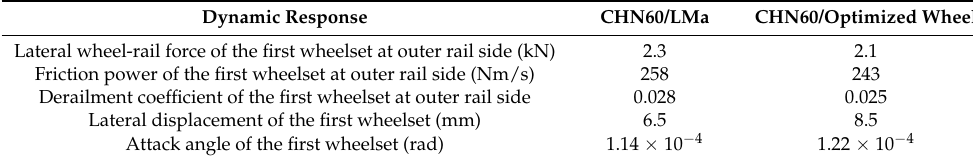
Figure 24. Vehicle curve negotiation performance indexes. ( a ) Lateral displacement of the first wheelset; ( b ) Yaw angle of the first wheelset; ( c ) Wheel friction force of the first wheelset at the outer rail side; ( d ) Derailment coefficient of the first wheelset at the outer rail side; ( e ) Lateral wheel-rail force of the first wheelset at the outer rail side. Table 2. Maximum dynamic parameters for vehicle curve negotiation.